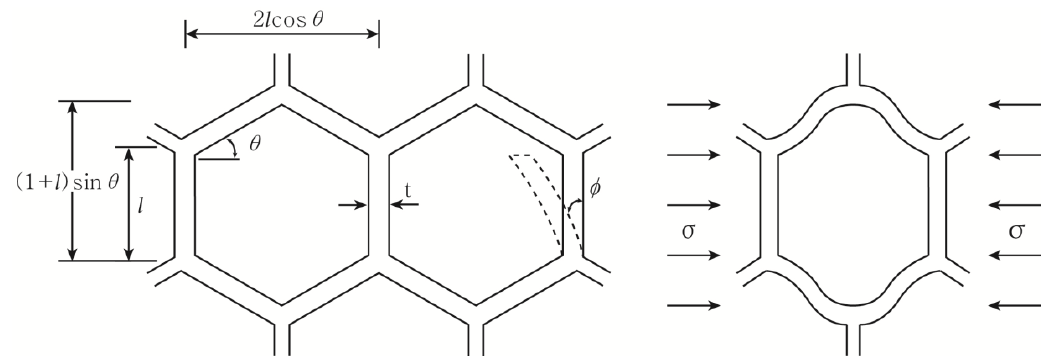
Figure 1. Cell deformations by cell wall bending and rotation in plastic collapses.